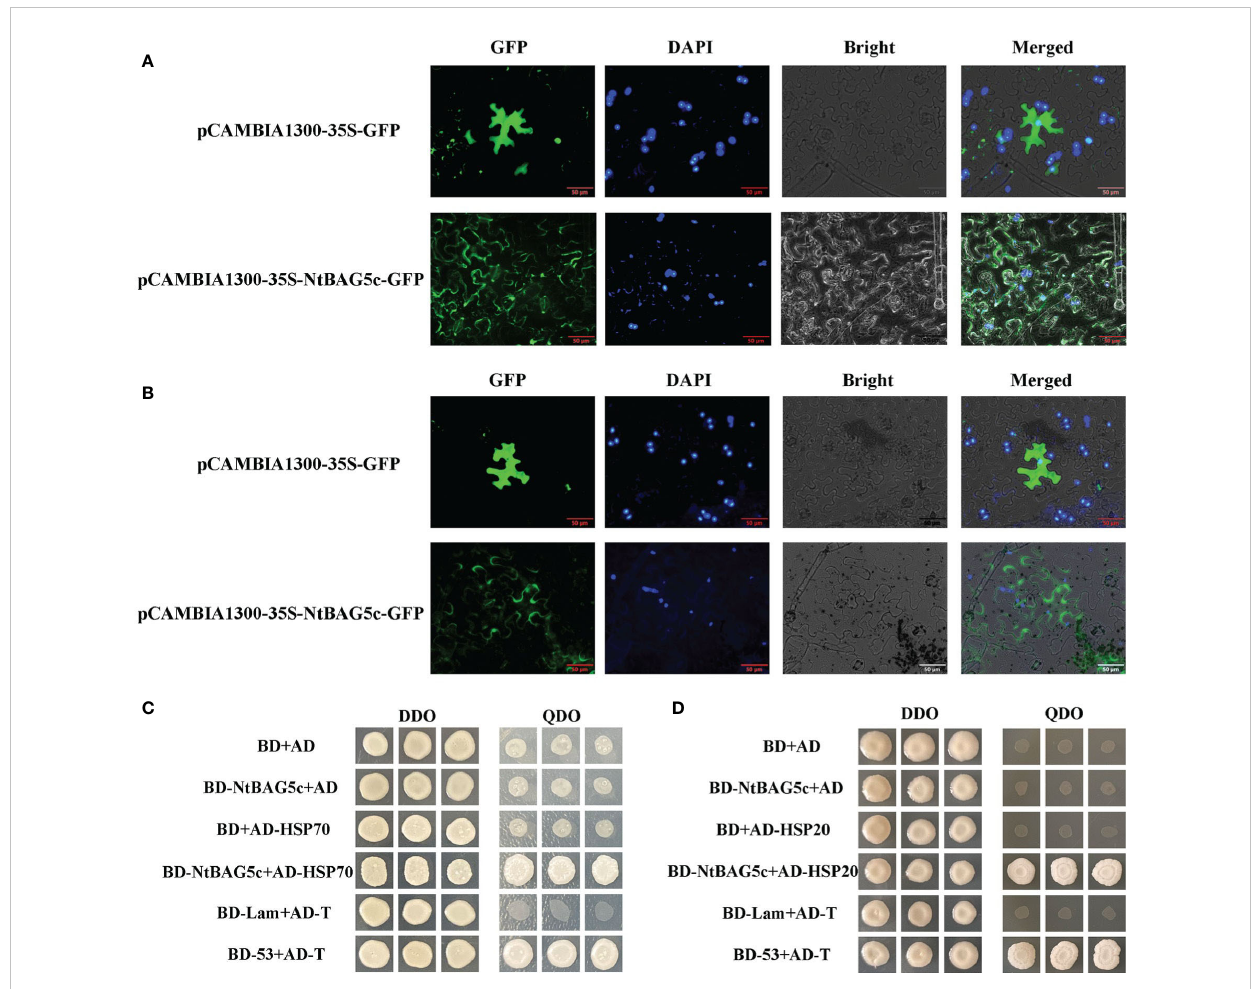
FIGURE 5 Localization of NtBAG5c in epidermal cells of N. benthamiana . (A) Subcellular localization analysis demonstrated that NtBAG5c is located in the cell membrane and cell wall. (B) After the wall separation, subcellular localization analysis indicated that NtBAG5c is located in the cell wall. GFP, green fl uorescent protein; DAPI, fl uorescent dye capable of binding strongly to DNA; Bright, white light; Merged, superposition of GFP, DAPI, and Bright. (C, D) Yeast two-hybrid assay. (C) The interaction of NtBAG5c and HSP70 in yeast cells. (D) The interaction of NtBAG5c and HSP20 in yeast cells. BD-53 + AD-T and BD + AD were used as positive and negative controls, respectively. The yeast co-transformed groups were grown on the SD Leu-Trp medium [double dropout (DDO), without leucine and tryptophan], and then grown on SD-Leu-Trp-His-Ade medium [quadruple dropout (QDO), with leucine, tryptophan, histidine, and